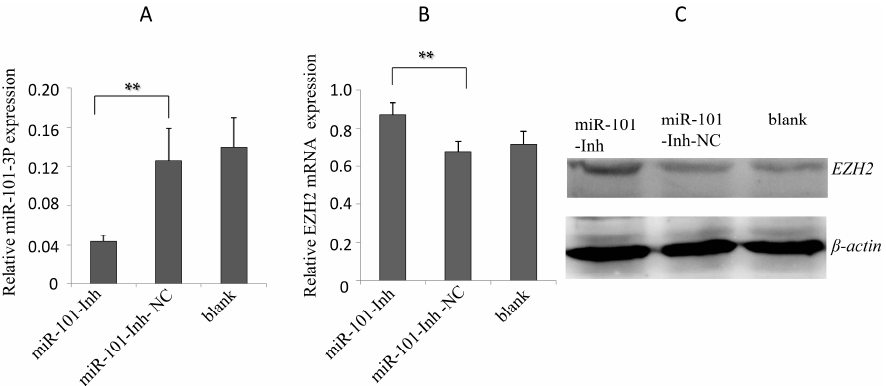
Figure 4. Inhibition of gga-miR-101-3p increased EZH2 expression. ( A ) Transfection of miR-101-Inh reduced the expression of gga-miR-101-3p in DF-1 cells, as detected by RT-qPCR; ( B ) Transfection of miR-101-Inh increased the mRNA expression of EZH2 in DF-1 cells. Error bars represent the mean ± SD of triplicate experiments; ( C ) Transfection of miR-101-Inh increased protein expression of EZH2 in DF-1 cells. A mock transfection was set as a blank, and the expression of β -actin was used as a loading control. Each experiment was repeated three times, and each sample was assayed in triplicate. The asterisks represented statistically significant differences (** p < 0.01).